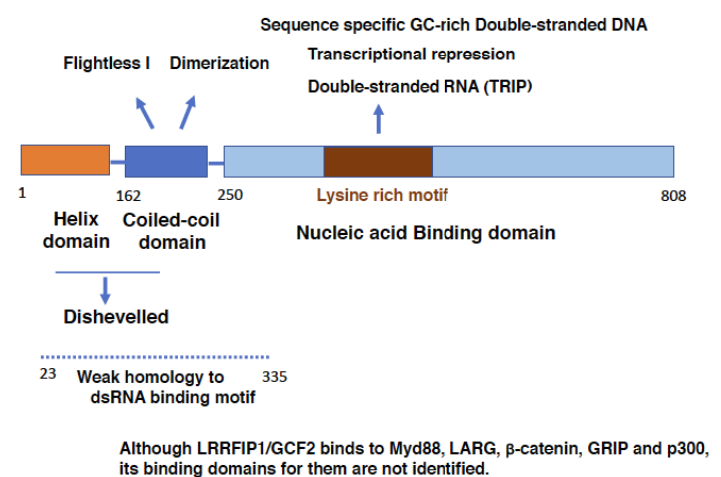
Figure 1. Domain structure of Leucine Rich Repeat of Flightless-1 Interacting Protein 1/GC- factor 2 (LRRFIP1/GCF2) protein. LRRFIP1/GCF2 protein consists of three domains; an N-terminal binding factor 2 (LRRFIP1/GCF2) protein . LRRFIP1/GCF2 protein consists of three domains; an N-terminal Helix domain [12], a central coiled-coil domain and a C-terminal Nucleic acid binding domain. The coiled-coil domain is necessary to interact with Flightless I and for self-dimerization [6,8]. The C-terminal Nucleic acid binding domain binds to DNAs and RNAs, and the middle of this domain, Lysine rich motif, is critical for sequence-specific binding to the double-stranded GC-rich DNA element, for transcriptional repression and for binding to dsRNA TRIP [4]. The dotted line is